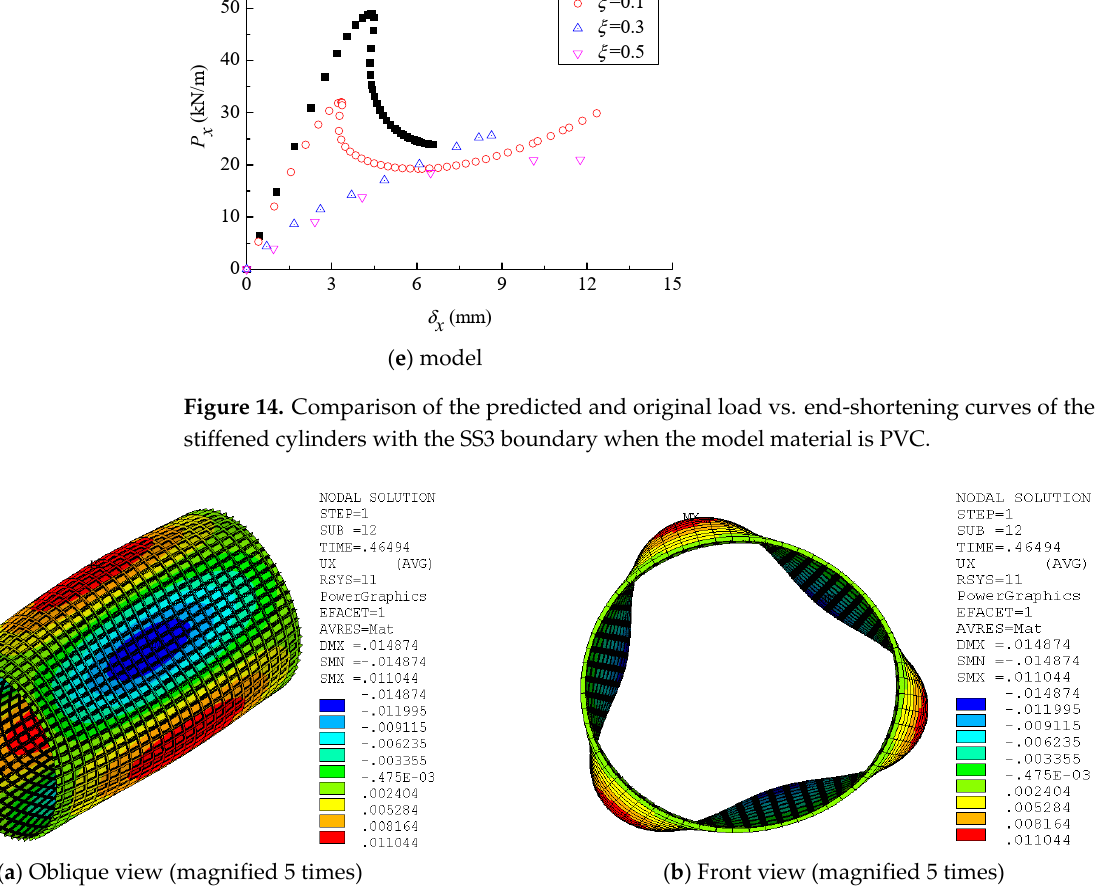
Figure 15. Radial displacement contour map at the upper critical point of the post-buckling path for the model of the T-type stiffened cylinder with the SS3 boundary condition when the material is PVC and ξ = 0.05.